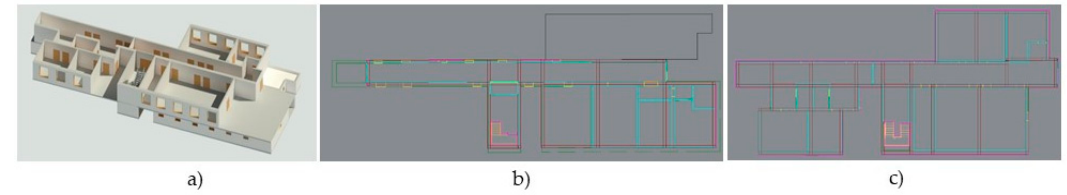
Figure 13. ( a ) Input BIM model. (b) DXF model of case study 1 and ( b ) DXF model of case study 2.